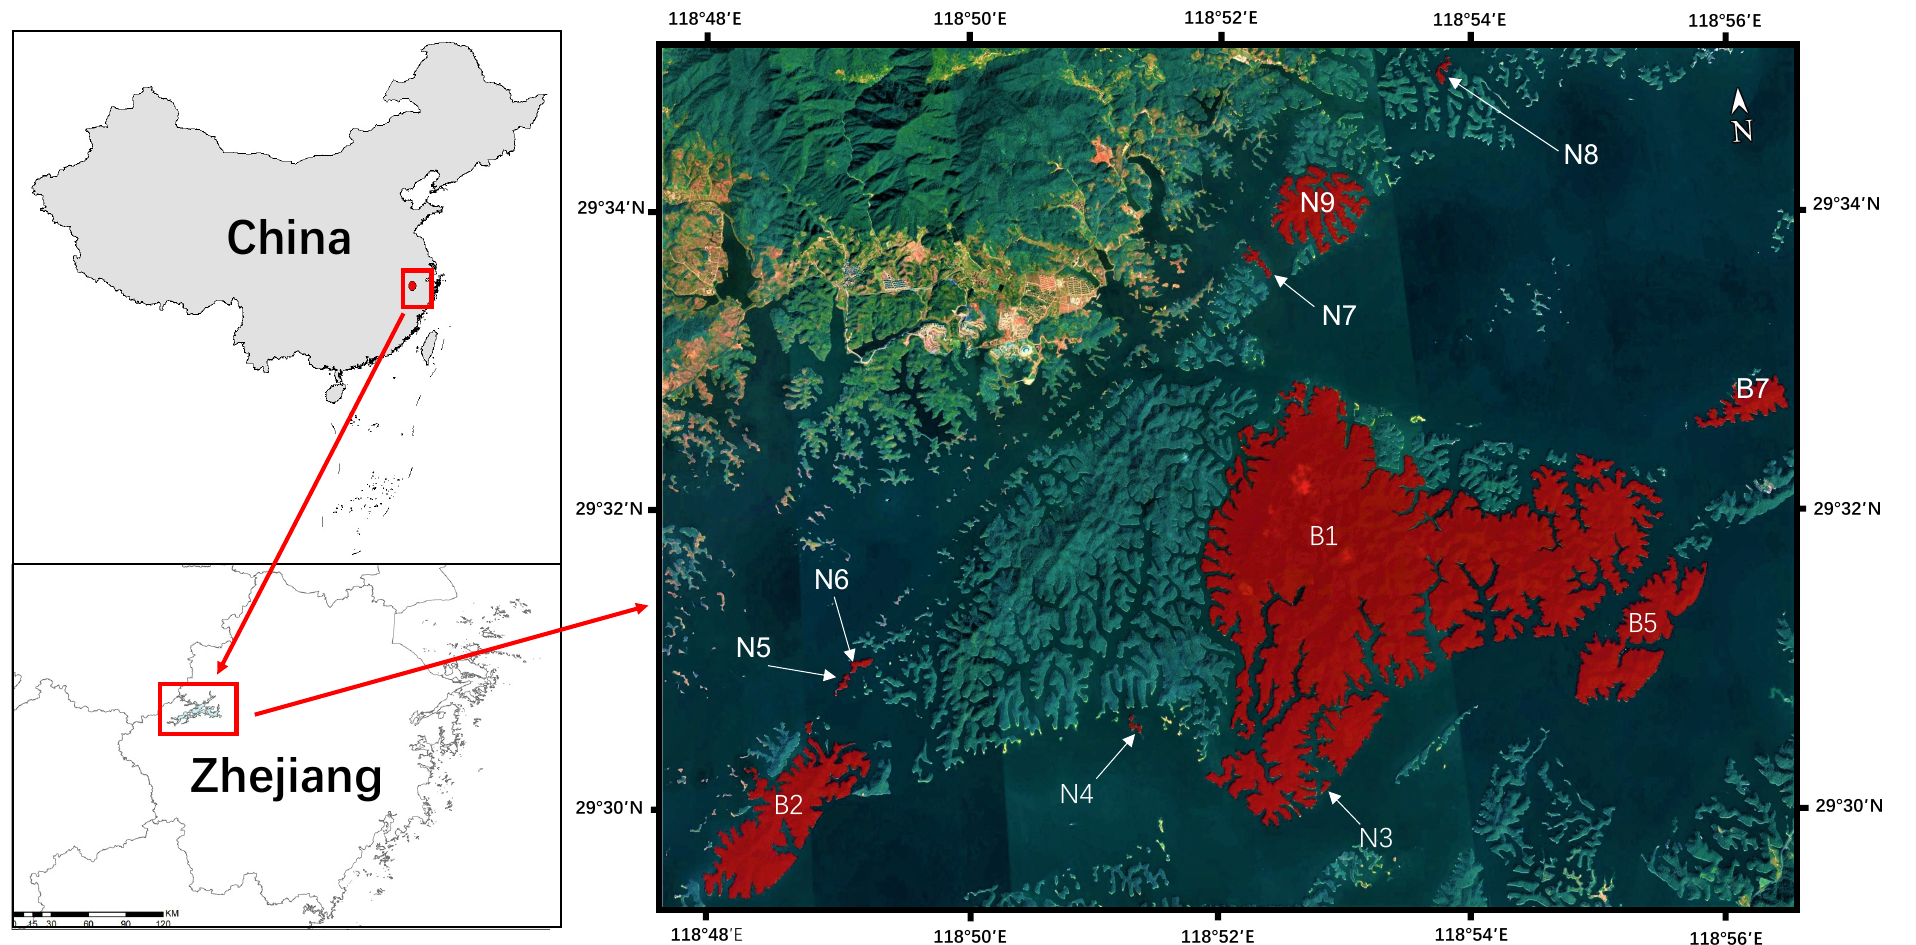
Figure 1. Map of the Thousand Island Lake (TIL) region and the distribution of studied islands (red